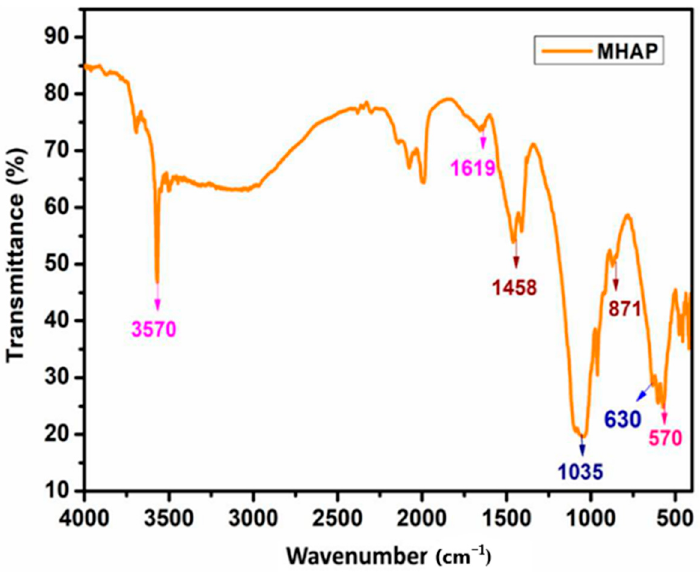
Figure 5. FT-IR spectra of magnetic hydroxyapatite NPs. Reprinted with permission from Ref. [44]. MDPI (2022).